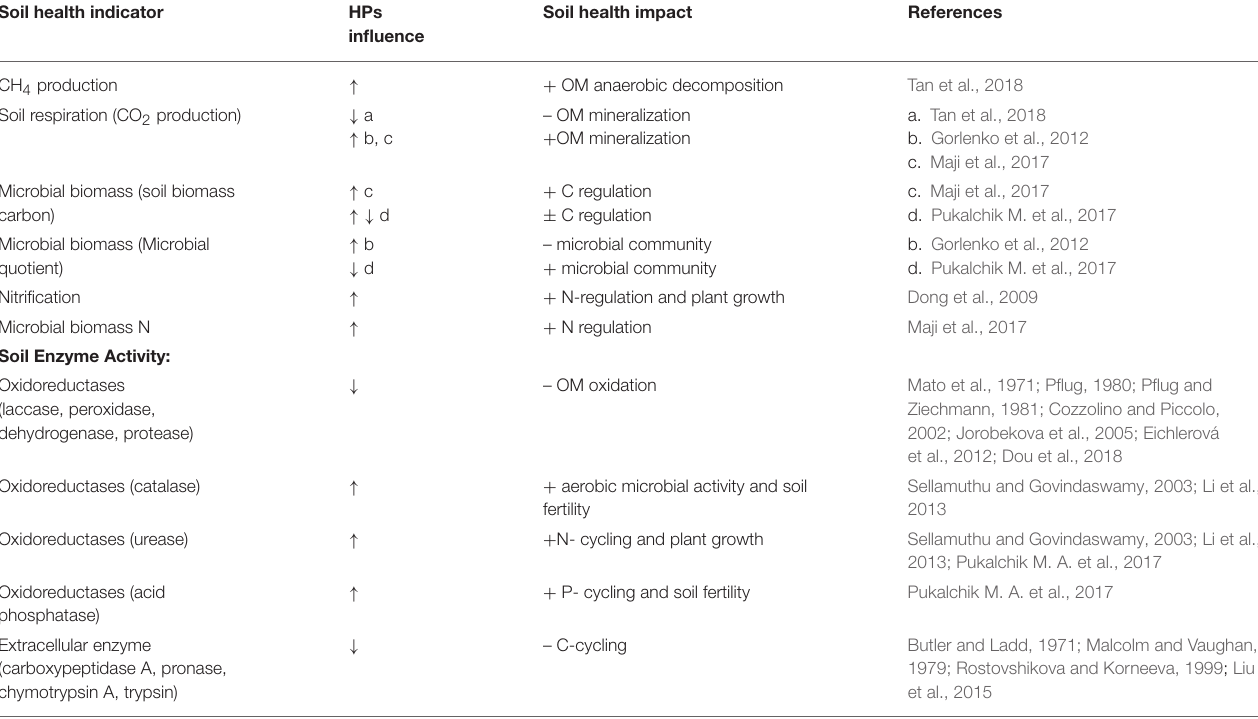
TABLE 1 | Impacts of HPs on key biological processes in soil (C and N, enzyme activities) and functional effects on soil